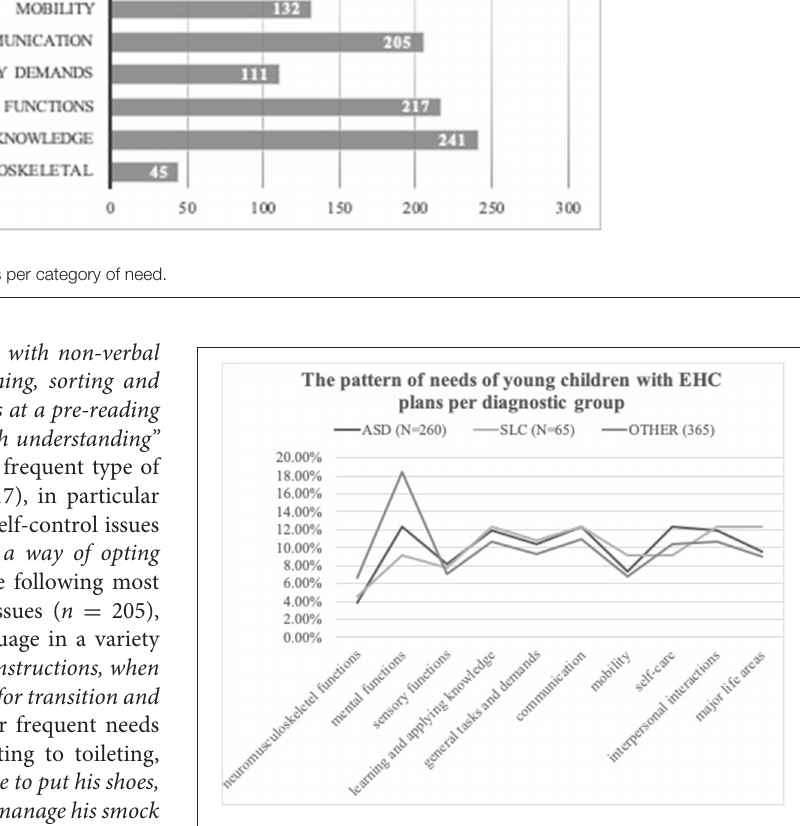
FIGURE 2 | The pattern of needs of young children with EHC plans per diagnostic